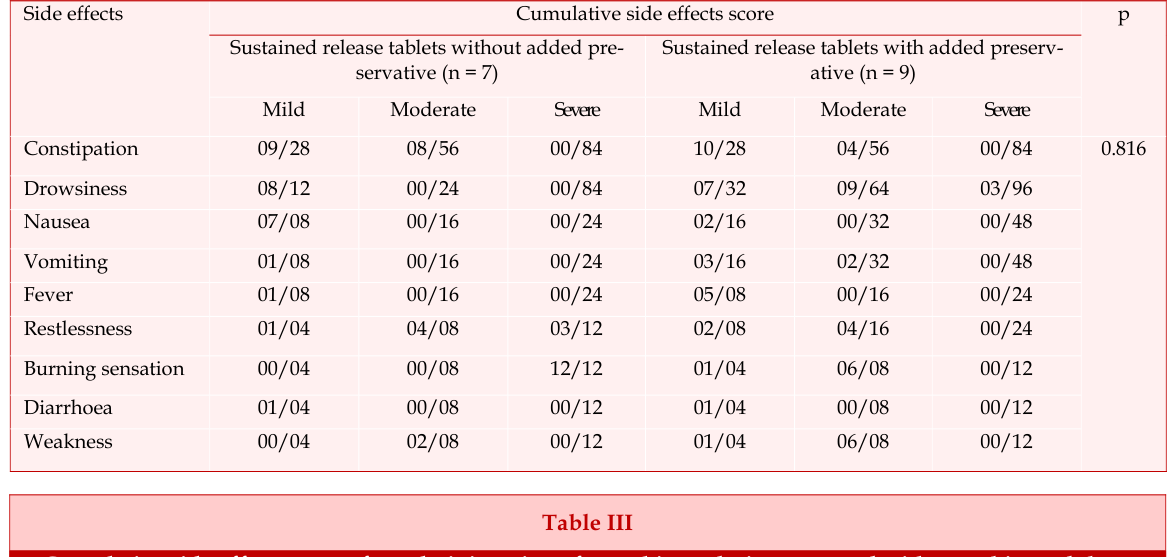
Cumulative side effects score after administration of morphine solution prepared with morphine sulphate sustained release tablets with and without added preservative